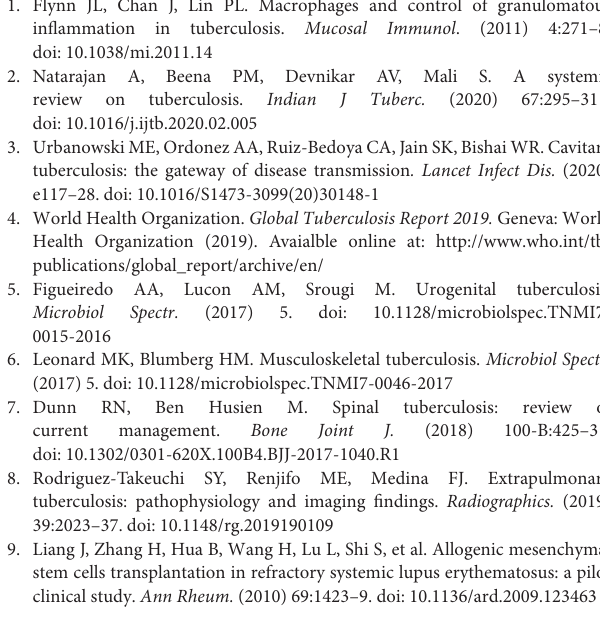
Supplementary Figure 1 | Bright-light microscopy analysis of the rabbit MSCs morphology on the 1st day of isolation (i) and following 3 days (ii) of cell cultivation.